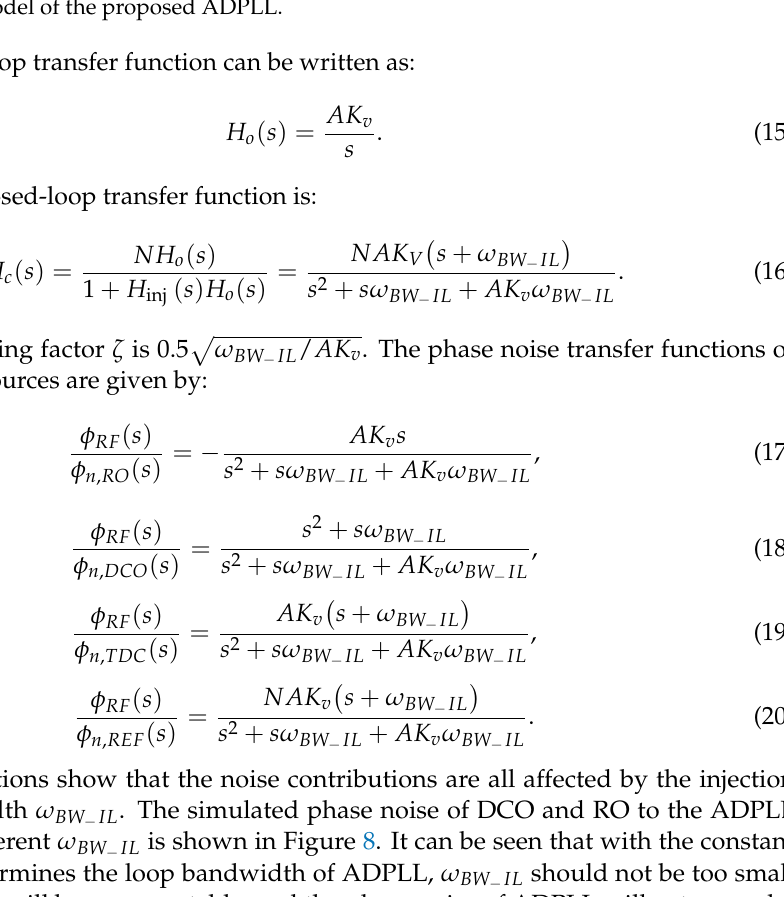
Figure 7. Noise model of the proposed